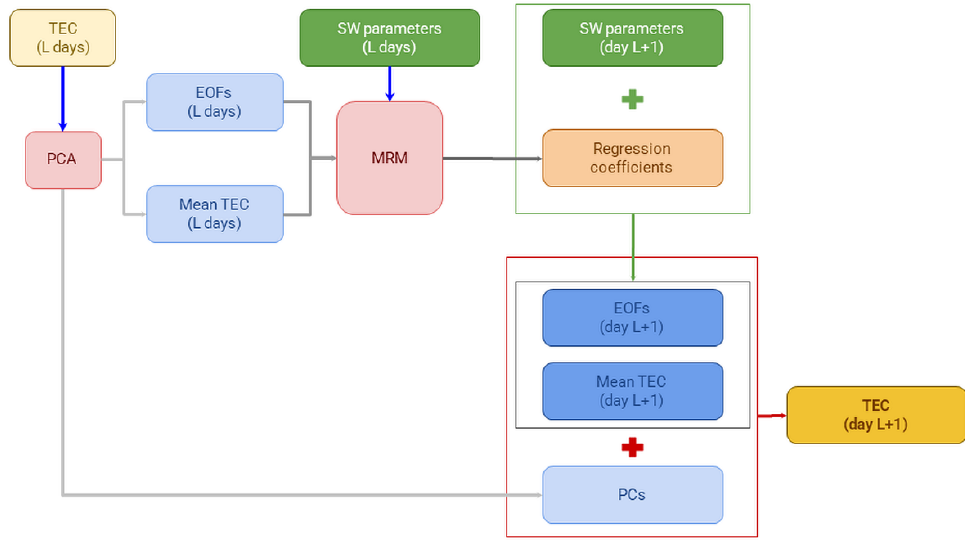
Figure 1. The PCA-MRM TEC model scheme.